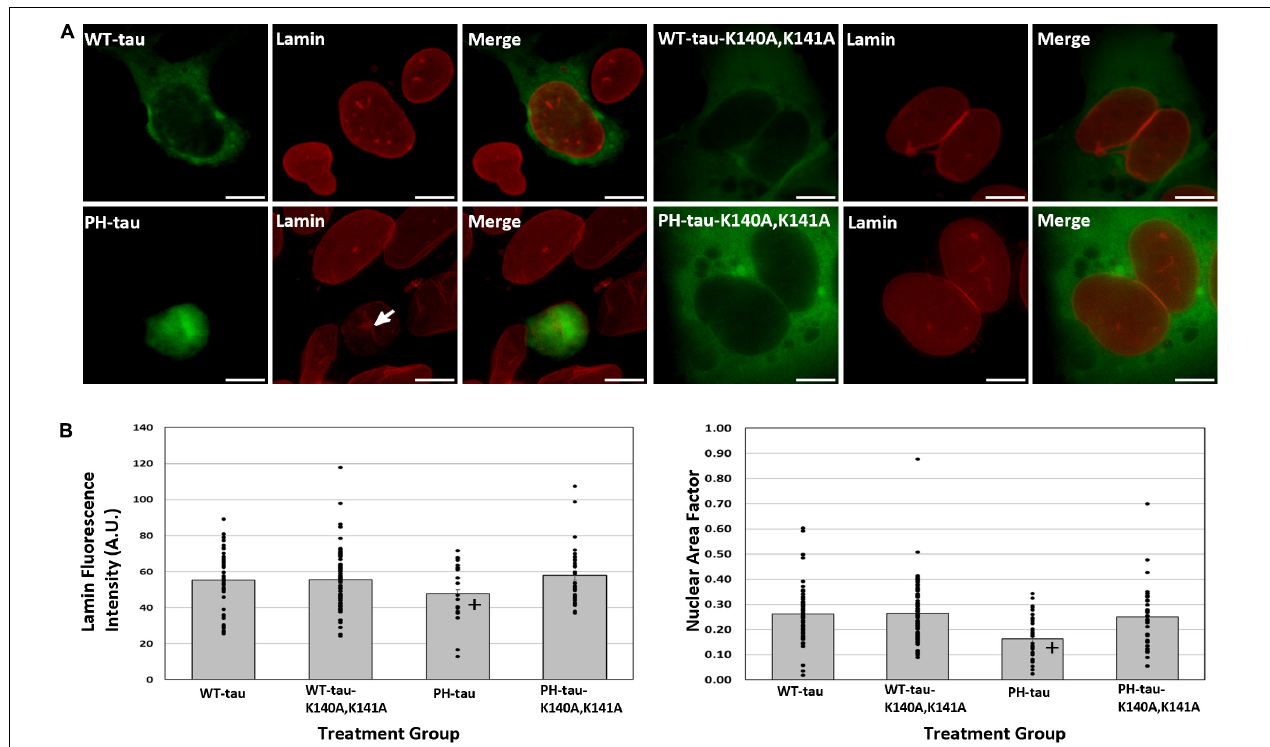
FIGURE 4 | Nuclear PH-tau disrupts the nuclear lamina. (A) HEK-293 cells were transfected with WT-tau, PH-tau, WT-tau-K140A,K141A, or PH-tau-K140A,K141A (green) and then immunostained for lamin-B1 (red). The arrow indicates invagination of the nuclear membrane in a PH-tau-positive cell. Scale bar indicates 15 µ m. (B) Left: The mean fluorescence intensity of lamin was quantified in individual tau-positive cells using ImageJ. The average fluorescence intensity across all cells ( n = 49 for WT-tau, n = 75 for WT-tau-K140A,K141A, n = 38 for PH-tau, n = 37 for PH-tau-K140A,K141A) was plotted, with error bars showing SEM. The bars are overlayed with a dot plot showing the lamin fluorescence intensity for each cell. Data were analyzed using Welch’s ANOVA, and Games-Howell post-hoc test was used for pairwise comparisons The + indicates a significant difference between PH-tau and PH-tau-K140A,K141A ( p = 0.008). No significance was detected in comparing WT-tau and PH-tau. Right: ImageJ was used to quantify the area and roundness of each tau-positive nucleus ( n = 49 for WT-tau, n = 75 for WT-tau-K140A,K141A, n = 38 for PH-tau, n = 37 for PH-tau-K140A,K141A), which were then multiplied to obtain the nuclear area factor (NAF). The mean NAF across all cells is plotted, with error bars to show SEM. This plot is overlayed with a dot plot indicating NAF values from individual nuclei. Data were analyzed using Welch’s ANOVA, and Games-Howell post-hoc test was used for pairwise comparisons The + indicates a significant difference in PH-tau compared to WT-tau ( p = 0.004) and PH-tau-K140A,K141A ( p = 0.037).